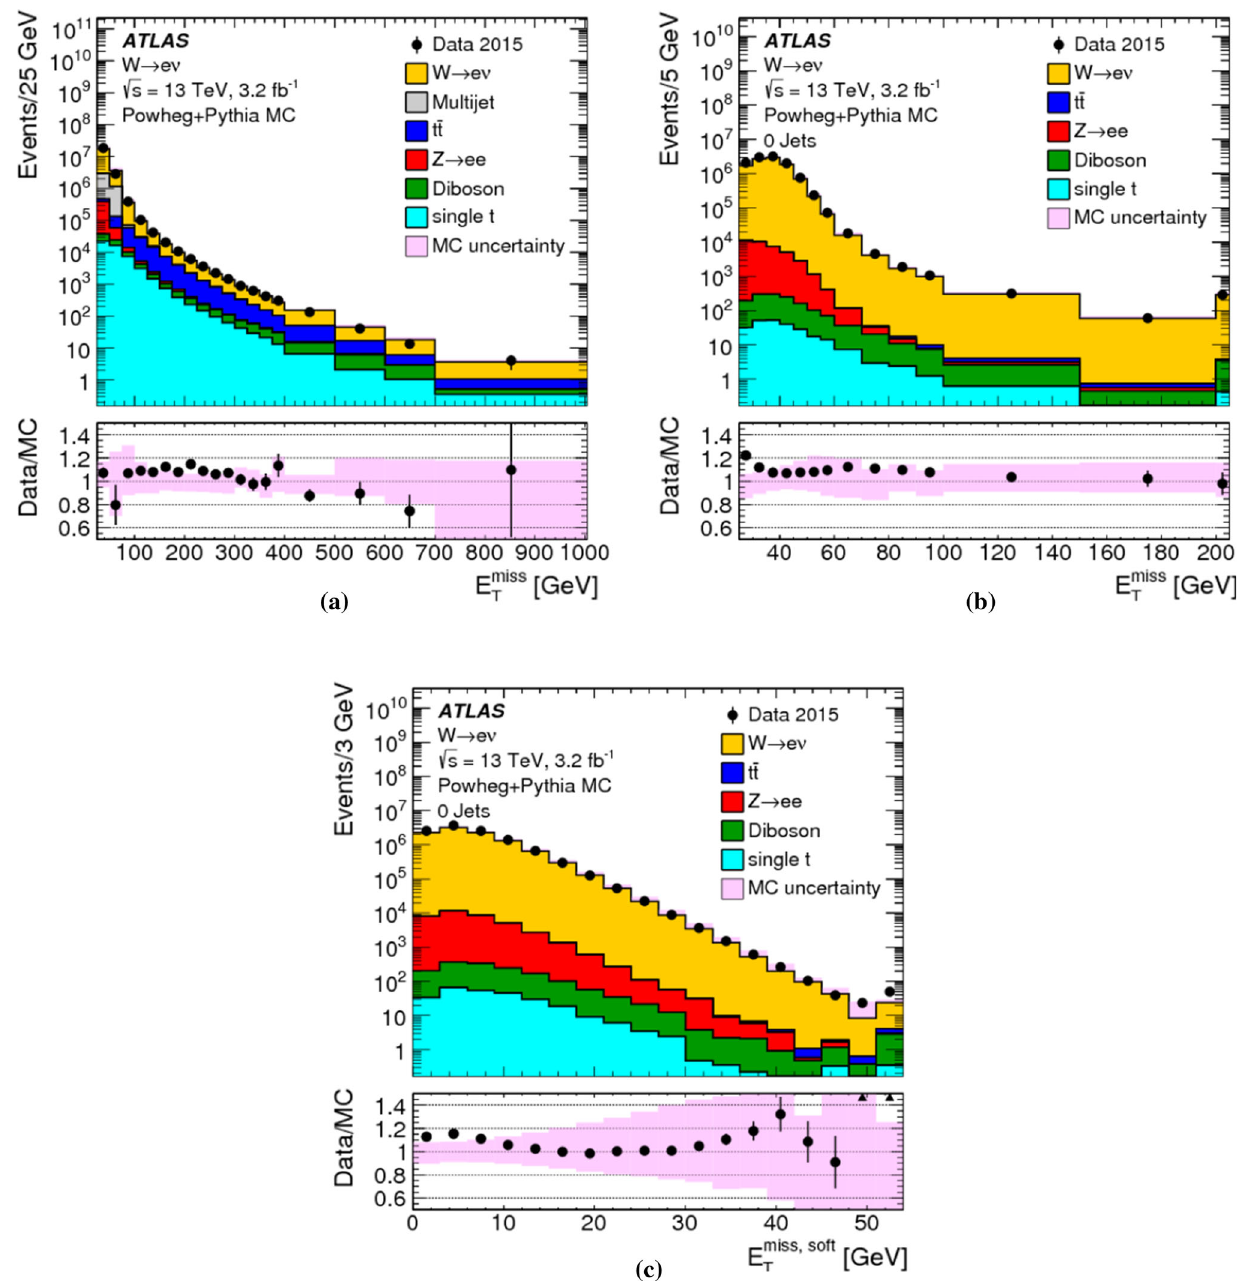
Fig. 3 Distributions of the total E miss in a the inclusive case and b areas indicate the total uncertainty for MC simulations, including the T overall statistical uncertainty combined with systematic uncertainties the N jet = 0 case, as well as c the soft term E miss , soft reconstructed T comprising contributions from the electron, jet, and the soft term. The in N jet = 0 events with W → e ν in data. The expectation from MC last bins contain the respective overflows. The respective ratios between simulation is superimposed and includes all relevant background final data and MC simulations are shown below the distributions, with the states passing the event selection. The inclusive E miss distribution from T shaded areas indicating the total uncertainties for MC MC simulations contains a small contribution from multijet final states at low E miss , which is absent for the N jet = 0 selection. The shaded T